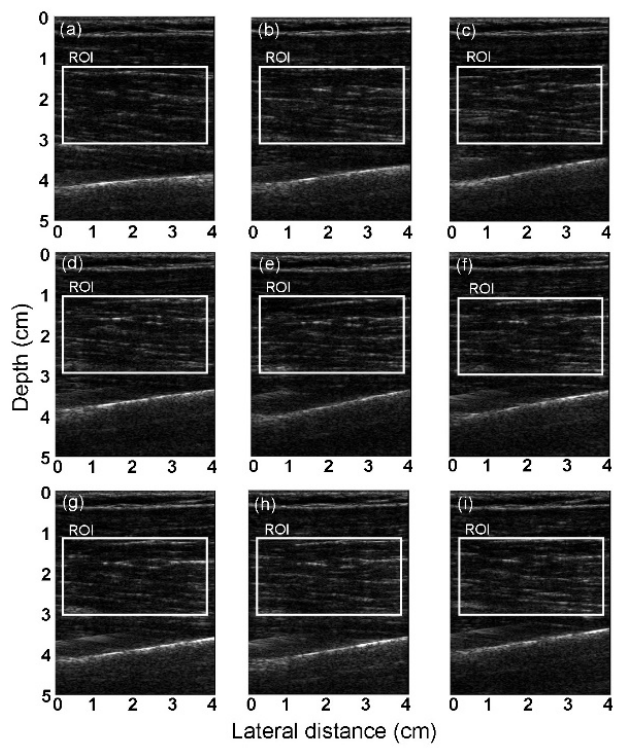
Figure 3. ( a – i ) B-ultrasound images of volunteer 1 every 5 s during the SC process.